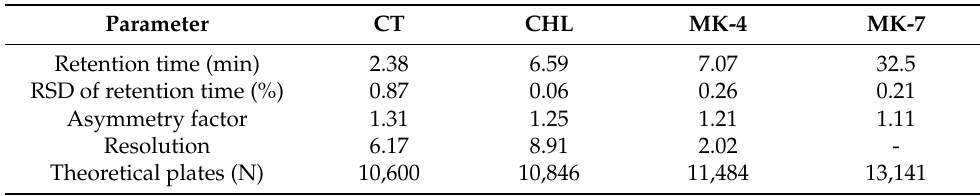
Table 1. Chromatographic parameters.